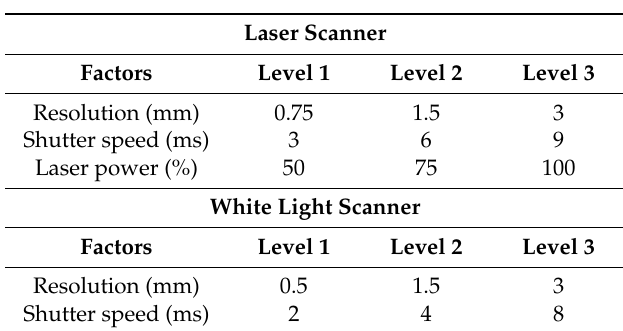
Table 2. Scanning factors with their levels.